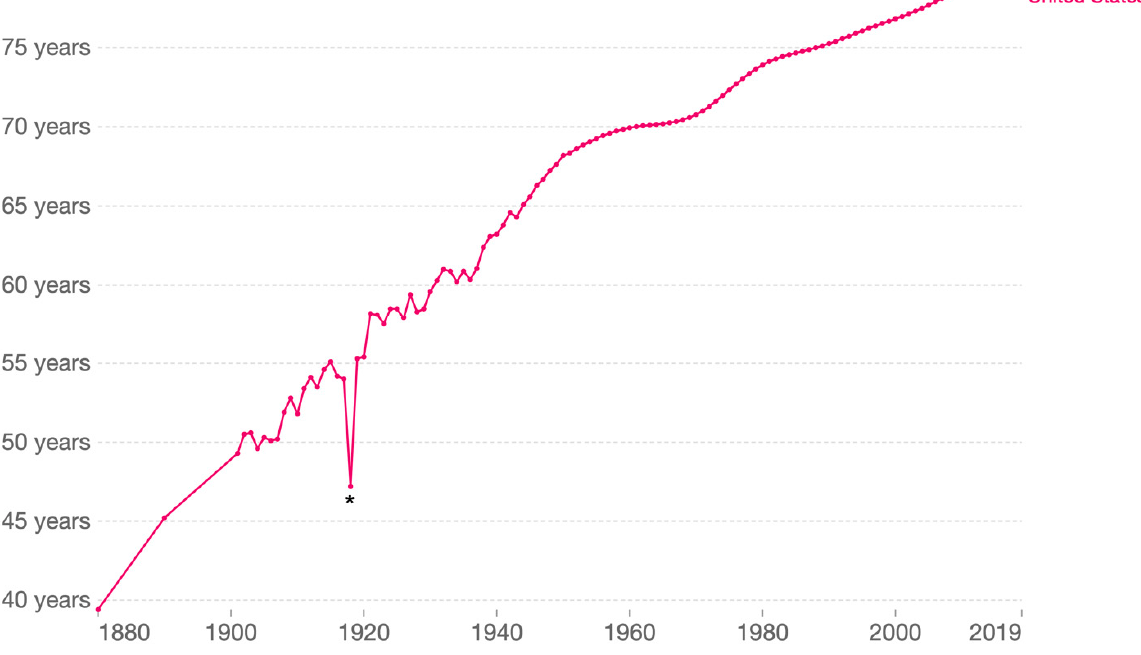
Figure 1. Life expectancy in the United States 1880–2019. Shown is period life expectancy. Note the impact of the 1918 influenza pandemic (*). Taken from OurWorldInData.org/life-expectancy. It did not take long for an RNA virus to wreak global havoc on the 21st century.